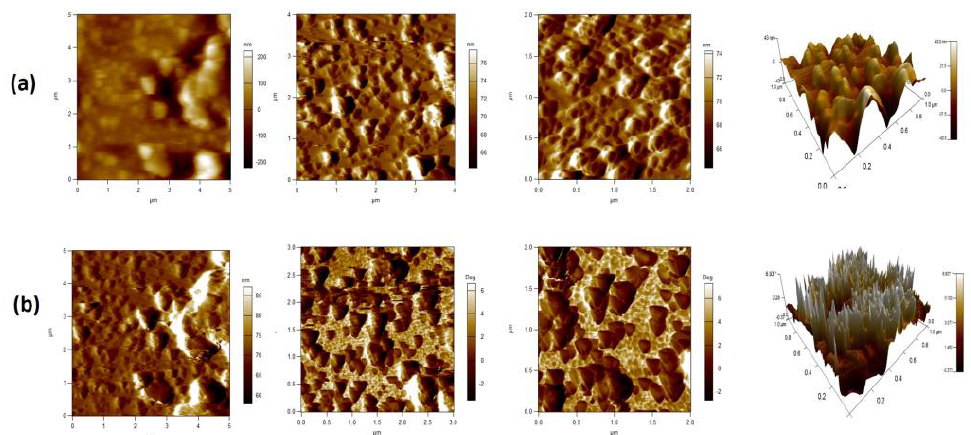
Figure 6. Surface topographical analysis for ( a ) BCP and ( b ) Ag-BCP. 344 The XPS analysis was used to determine the elemental composition of Ag-BCP sam- 345